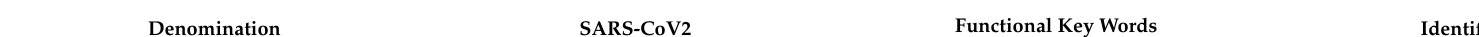
Table 1. The list of genes identified in familial sarcoidosis (F-SARC) and control individuals (CTRL) and belonging to the SARS-CoV2 GHI (Gordon and Hoffmann interactome) [9,10]. Lines highlighted in pink indicate the genes found in both the F-SARC-CoV and the F-CTRL control series 3.3. Gene set enrichment of genes identified in familial sarcoidosis and controls.